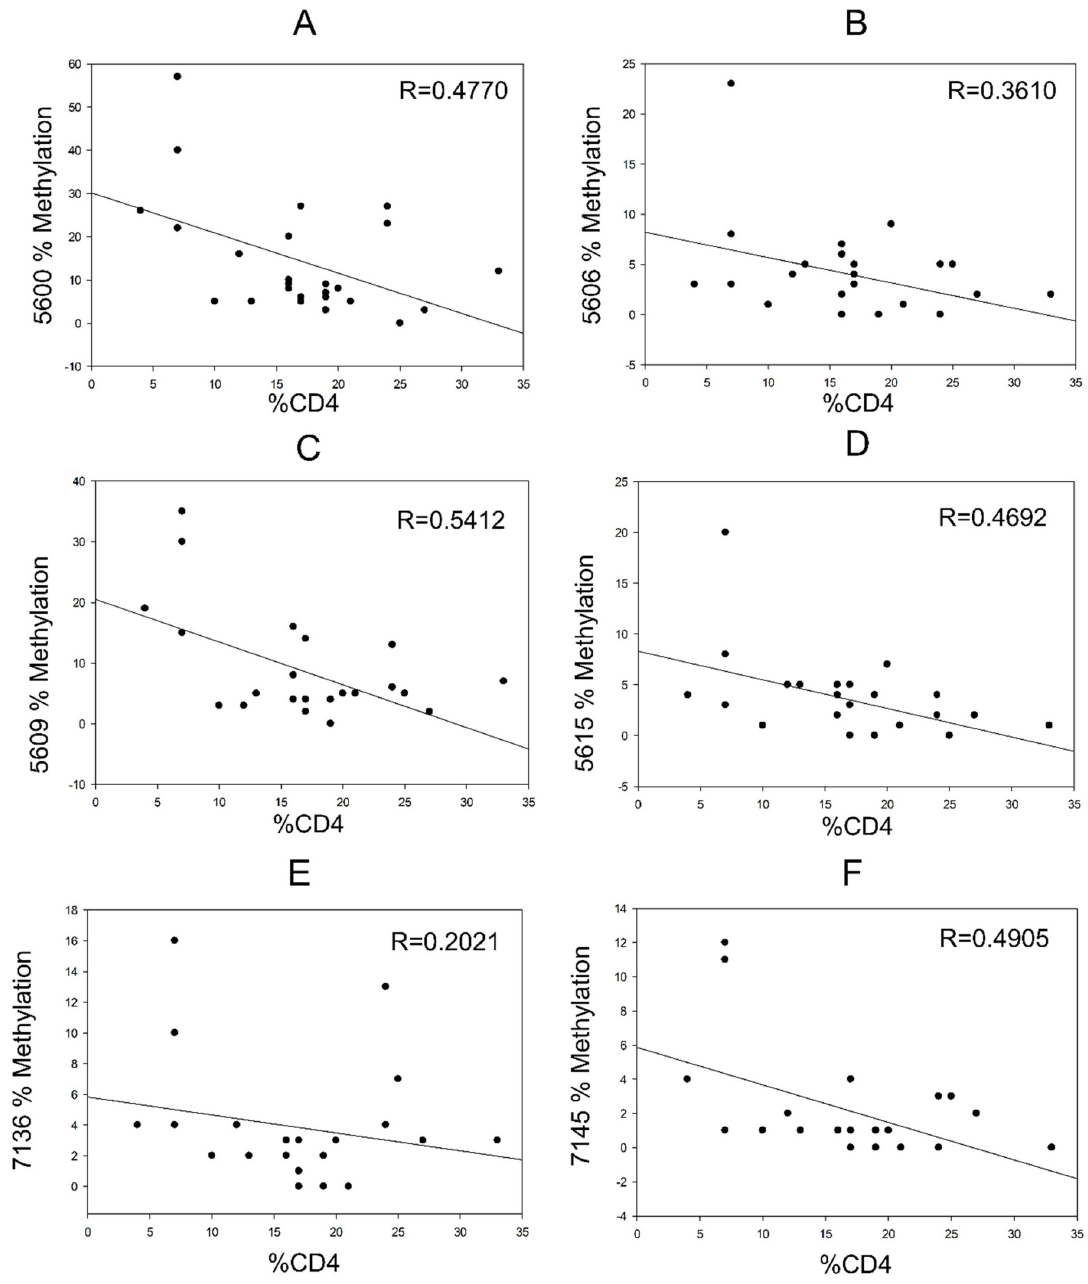
Fig 4. Correlation between the percentage of HPV16 L1 gene methylation and the percentage of CD4 counts in AIN3 cases. There was an inverse correlation between CpGs 5600, 5606, 5609, 5615, 7136, and 7145 methylation and a low percentual CD4 count. A moderate correlation (R = 0.4692–0.5412) was found at CpGs 5600, 5609, 5615, and 7145.